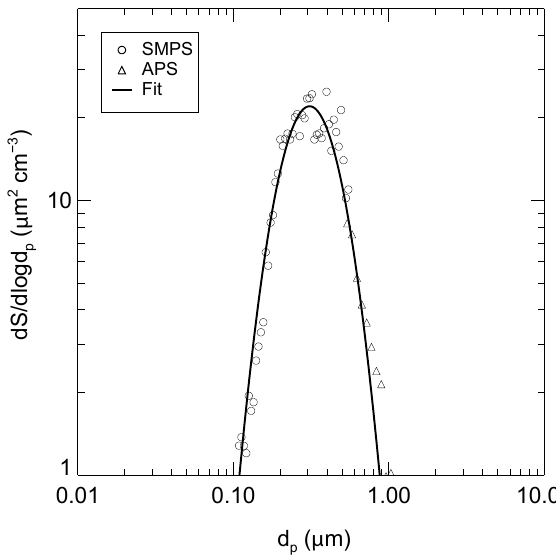
Figure 2. Aerosol surface distribution for dust particles (Arizona Test Dust) with lognormal fit: d med, surf = 0 . 32µm; σ surf = 1 . 55 (exp.